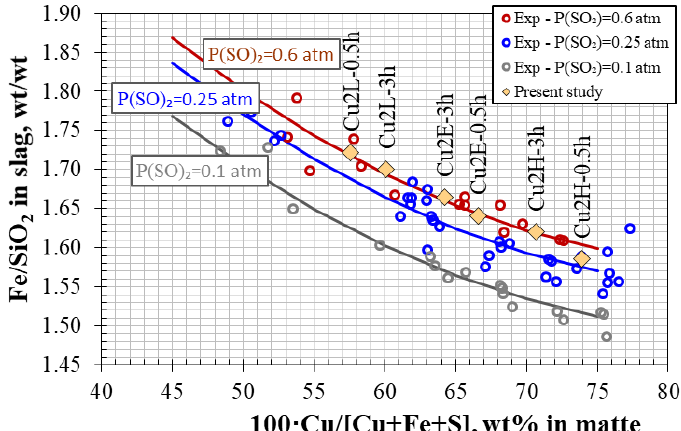
Figure 12. Fe/SiO 2 in slag as function matte grade in the slag – matte – metal – tridymite experiments in the Cu-Fe-O-S-Si system at 1200 °C, fixed p (SO 2 ) = 0.6 atm. Present experiments (0.5 and 3 h at p (SO 2 ) = 0.6 atm) are indicated by yellow diamond symbols. Other data are from experiments using open- type SiO 2 substrate for 24 h obtained in previous studies [34 – 36]. Table 4. Phase compositions for semi-open slag – matte – metal – tridymite experiments in the Cu-Fe-